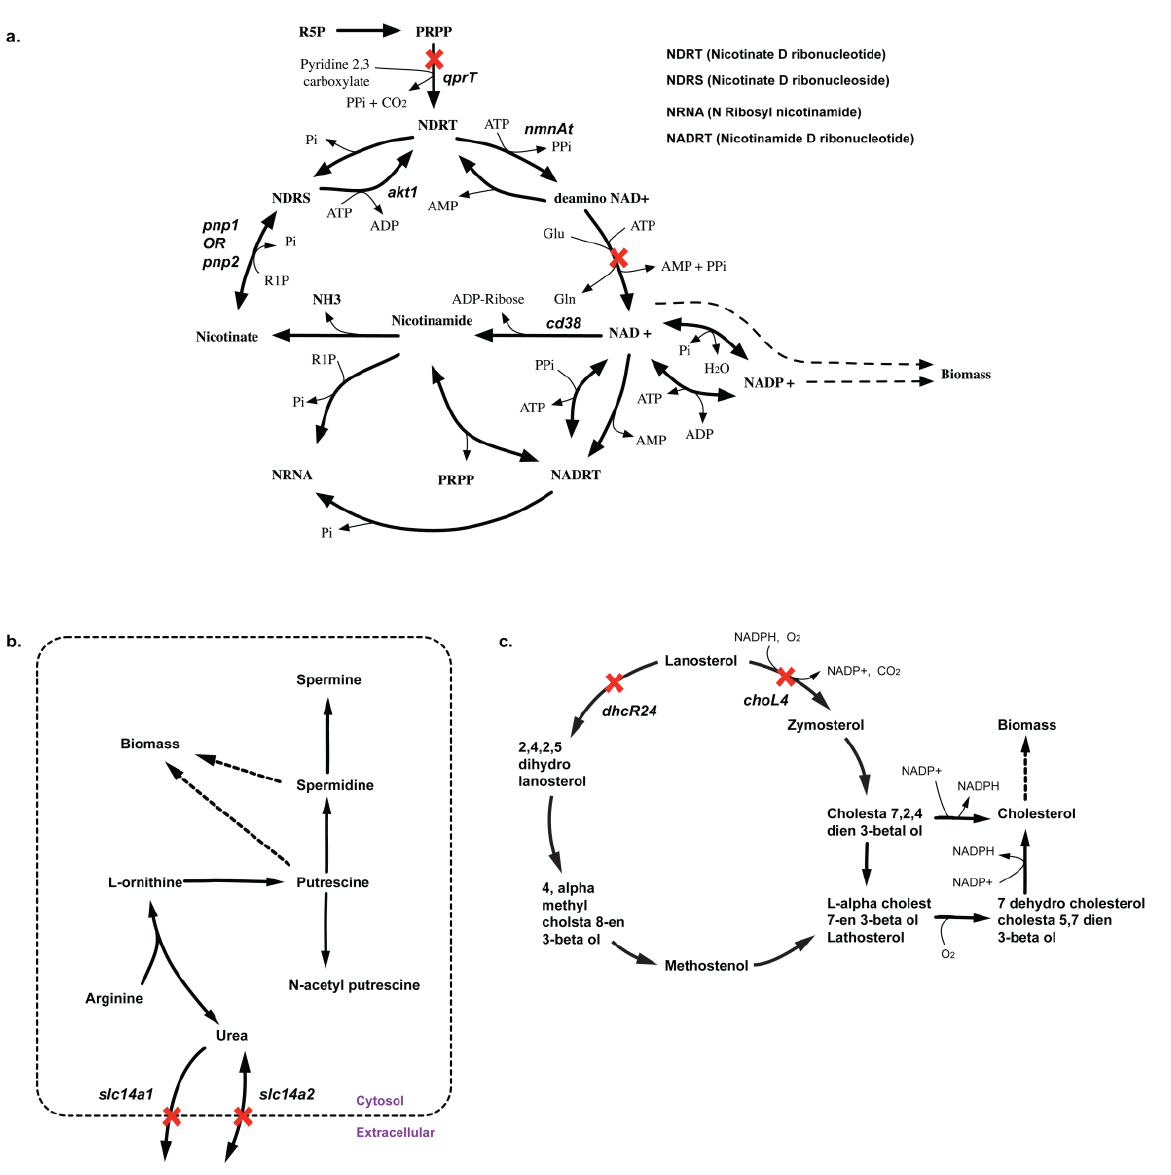
Figure 12. Pathways showing how biomass precursor(s) formation is blocked upon deletion of lethal gene(s). ( a ) Shows why qprT gene is essential for NAD-biosynthesis ( b ) Shows how deletion of slc14a1 and slc14a2 prevents synthesis of spermidine and putrescine ( c ) Shows how deletion of dhcR24 and choL4 prevents cholesterol biosynthesis. In addition to manual inspection of in silico synthetic lethal suggestions for non-intuitive examples, we performed a node centrality analysis synthetic lethal landscape for CHO 1.2 (see Figure 13). Node centrality analysis is an important tool of querying complex networks (such as gene-association networks) to identify key nodes that have the maximal influence on the topology of the network [92].